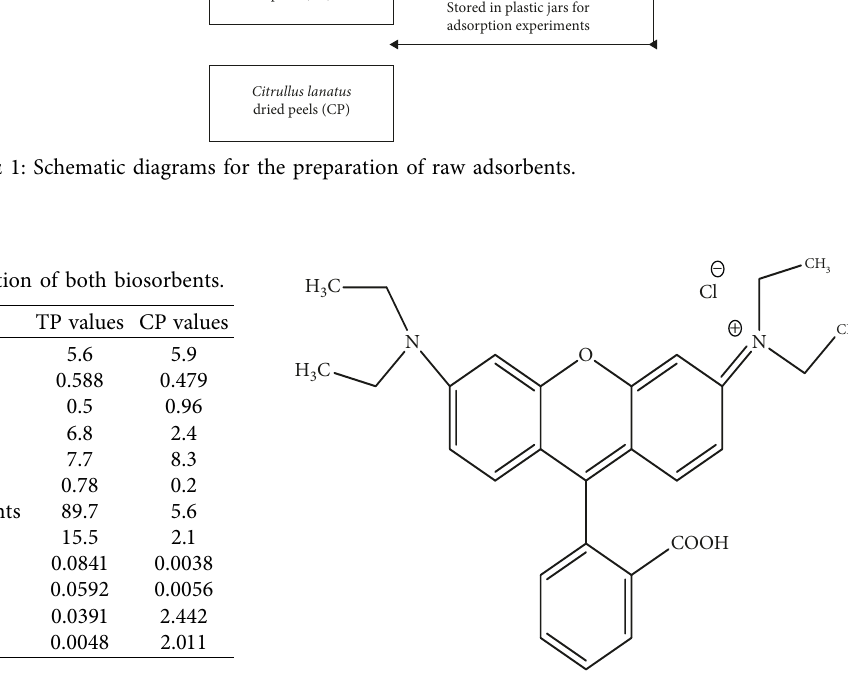
Figure 2: Chemical structure of Rhodamine